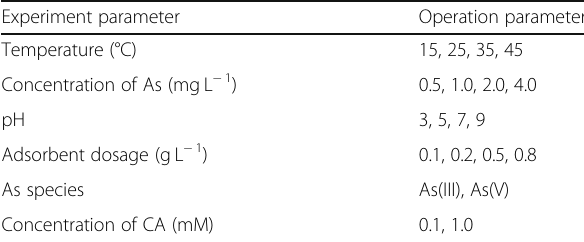
Table 1 Experiment parameter Experiment parameter Operation